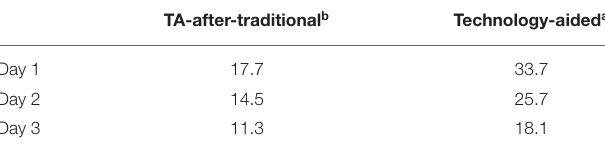
TABLE 3 | Mean daily vaccination counts per team for Traditional, Technology-aided, and Technology-aided after traditional vaccination methods. TA-after-traditional